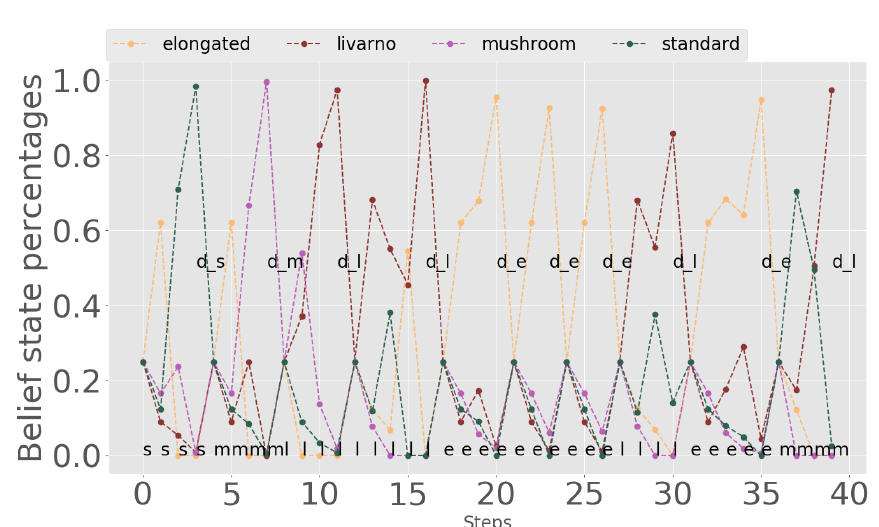
Figure 8. Belief state evolution for single-position observation experiments.